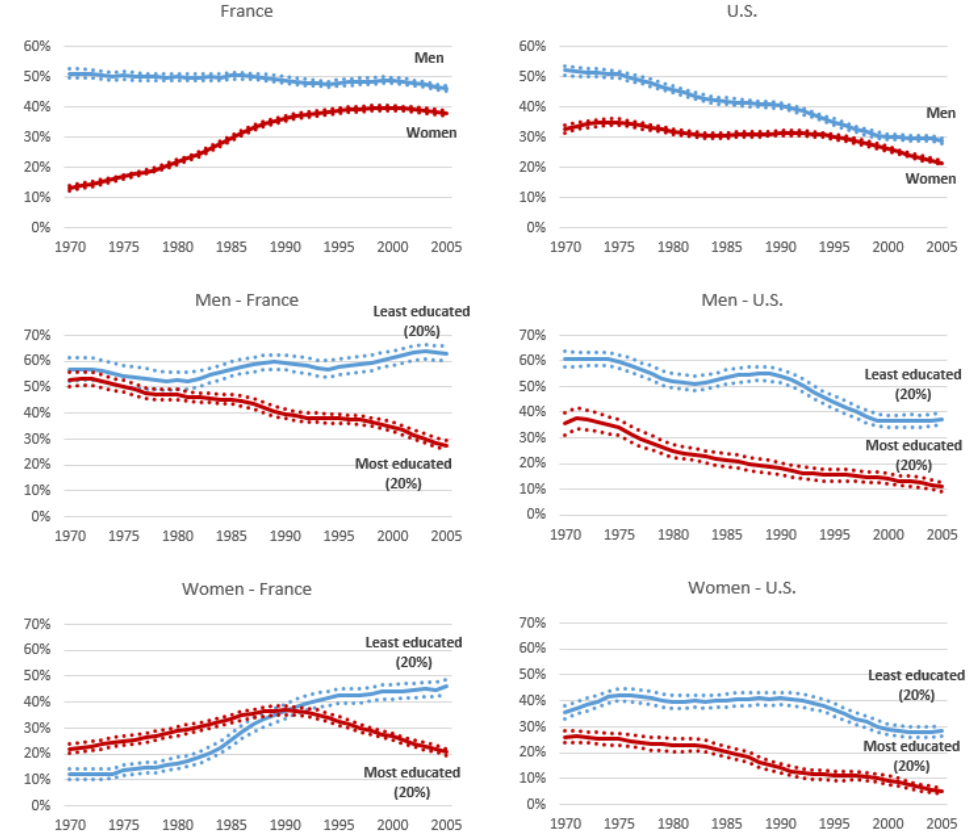
Figure 1. Smoking prevalence in men and women aged 30–34 years from 1970 to 2005, France and the United States (% and 95% confidence intervals). Source: 2010 French Health Barometer, 2010 U.S. National Health Survey Adult Sample.